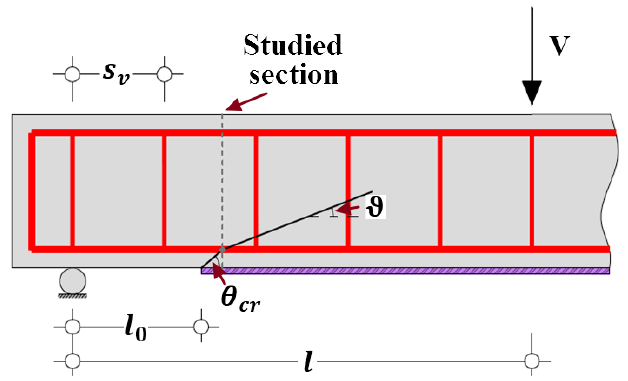
Figure 17. Geometries and configurations of FRP-strengthened RC beams.